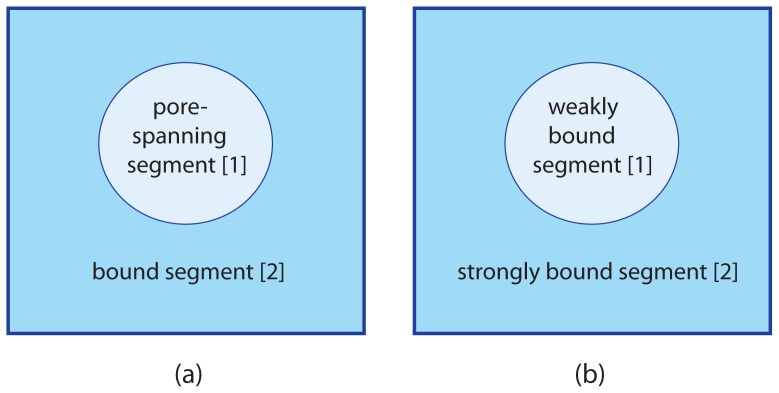
(a) Top view of a partially supported membrane spanning a single circular hole or pore within the rigid support. The membrane consists of a pore-spanning or unbound segment
S[1] with area
A[1] and a bound segment
S[2] with area
A[2]; and (b) Membrane supported by a chemically patterned surface with a single, circular surface domain that attracts the membrane less strongly than the surrounding substrate. The membrane is then divided up into a weakly bound segment
S[1] with area
A[1] and a strongly bound segment
S[2] with area
A[2]. If the circular surface domain does not attract or repel the membrane, the adhesion geometry in (b) is thermodynamically equivalent to the one in (a).